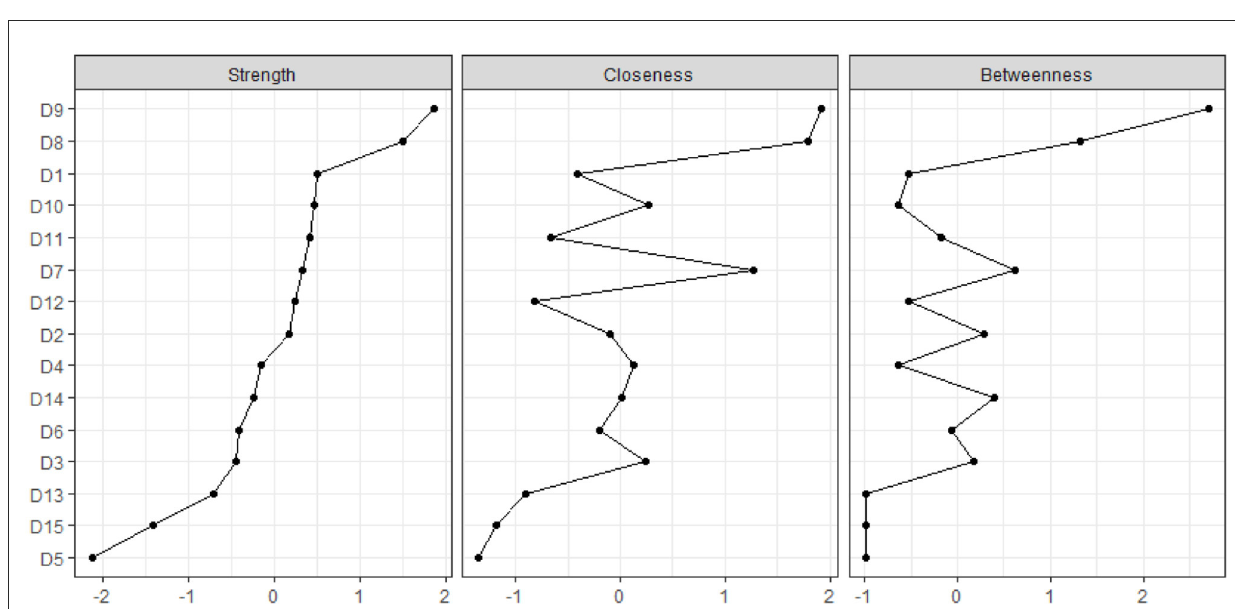
FIGURE2 Centrality measures of all symptoms within the network. The figure shows the centrality measures (i.e., strength, betweenness, and closeness) of all factors within the network